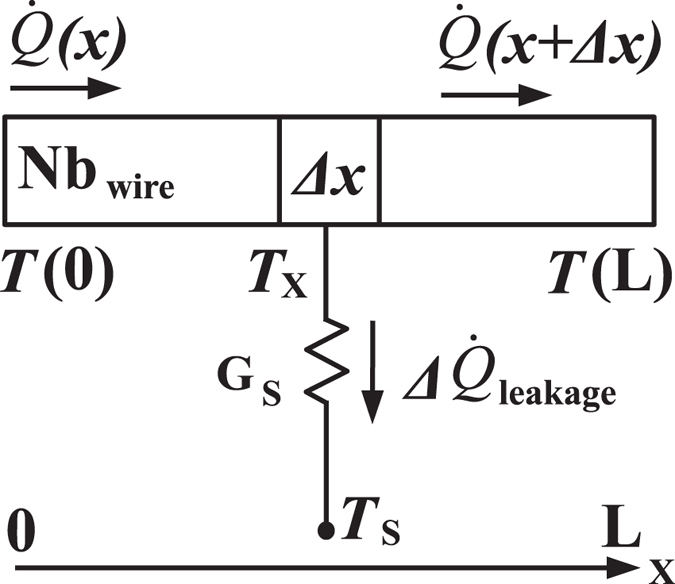
Continuous model.